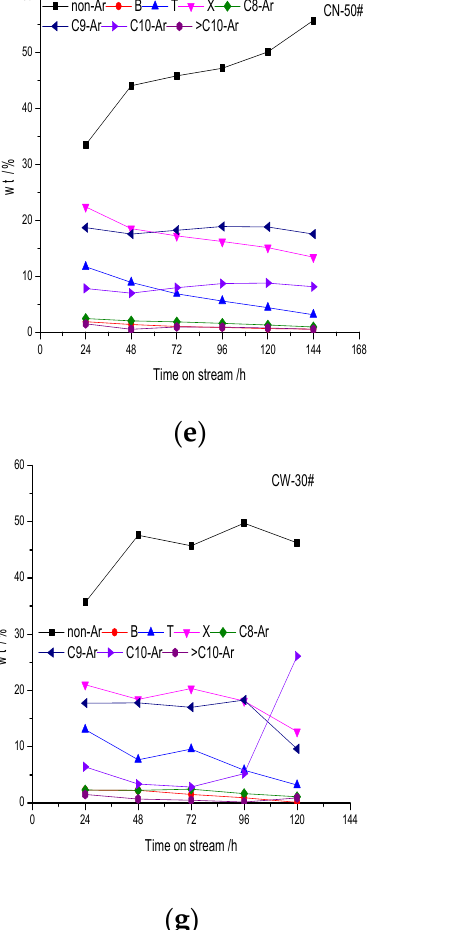
Figure 14. The change in oil composition with time on stream: ( a ) CZ; ( b ) CN ‐ 20; ( c ) CN ‐ 30; ( d ) CN ‐ 40; ( e ) CN ‐ 50; ( f ) CP ‐ 30; and ( g ) CW ‐ 30. The change in the hydrogen transfer index (HTI) with time on stream over the catalysts is shown in Figure 15. It can be seen that the HTI of all the catalysts decreases continuously with time on stream and that the downward trend gradually slows down. At the beginning of the reaction the HTI of the catalyst with less binder content is higher, and the HTI of CW-30 and CP-30 are close, lower than that of CN-30. The HTI of CZ decreased to 3.07 at 24 h and 1.06 at 48 h. Its reduction speed is the fastest, followed by CW-30; the third is CP-30; the fourth is CN-30; and CN-20 and CN-50 decreased slowly.